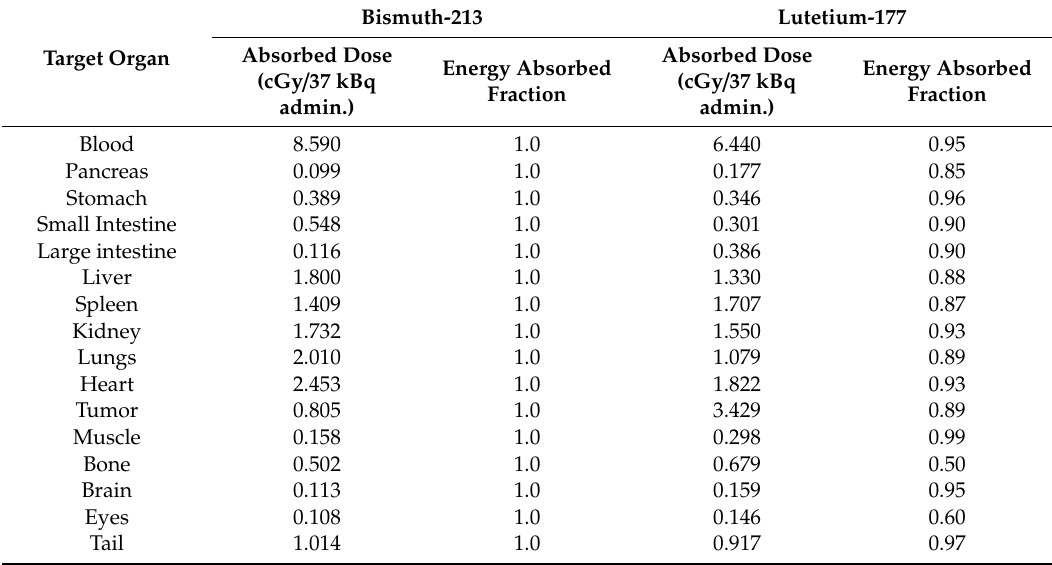
Table 1. Doses to the normal organs and melanoma tumors in mice delivered by 177 Lu-h8C3 and 213